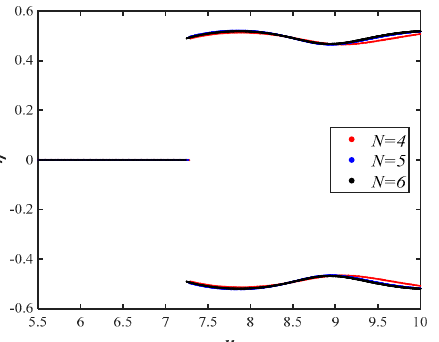
Figure 3. Convergence analysis of the Galerkin’s truncation approximation.